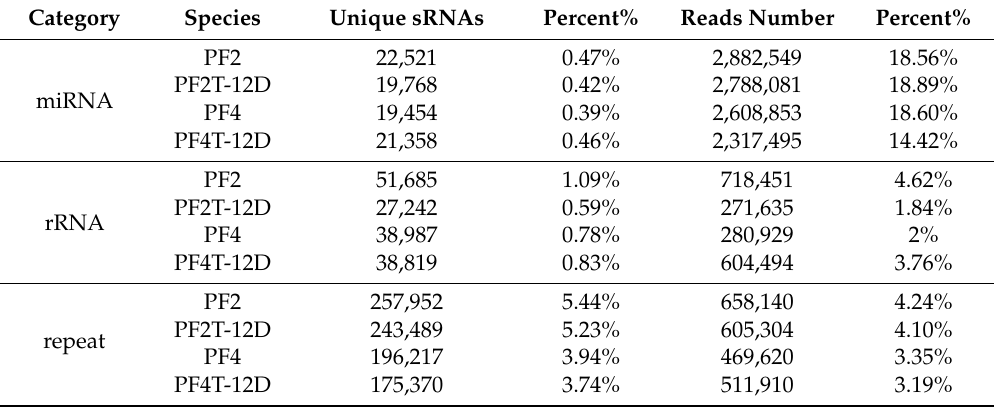
Table 3. Annotation of small RNA (sRNA) sequences in four libraries.